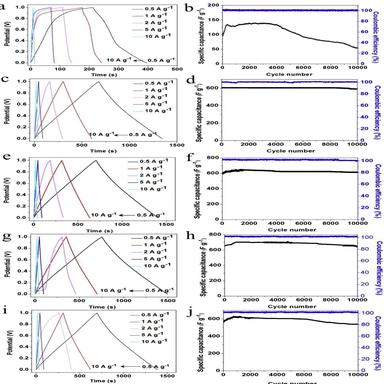
GCD curves of (a) pristine CoFe2O4, (c) CDC/CoFe2O4 composites (1), (e) CDC/CoFe2O4 composites (2), (g) CDC/CoFe2O4 composites (3) and (i) CDC/CoFe2O4 composites (4) at different current densities. Cycling stability and Coulombic efficiency of (b) pristine CoFe2O4, (d) CDC/CoFe2O4 composites (1), (f) CDC/CoFe2O4 composites (2), (h) CDC/CoFe2O4 composites (3) and (j) CDC/CoFe2O4 composites (4) and at 1 A g1 .